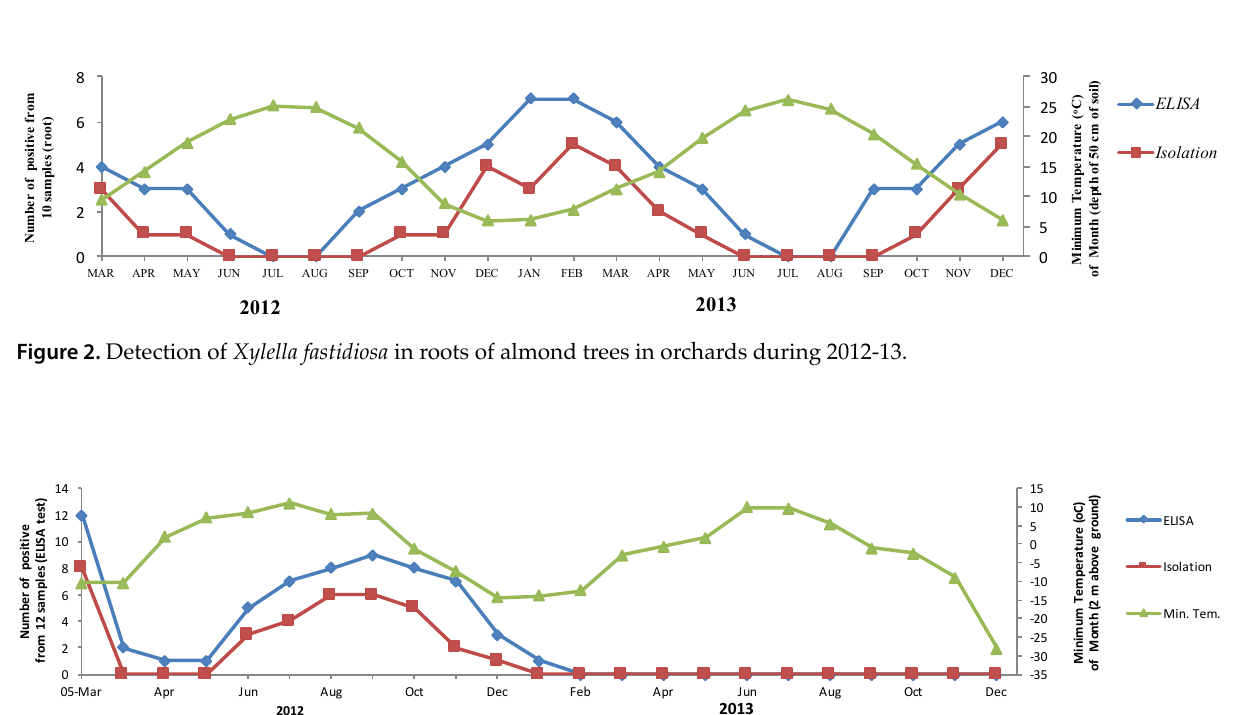
Figure 3. Detection of Xylella fastidiosa in leaves and shoots of almond trees in outdoor pots during